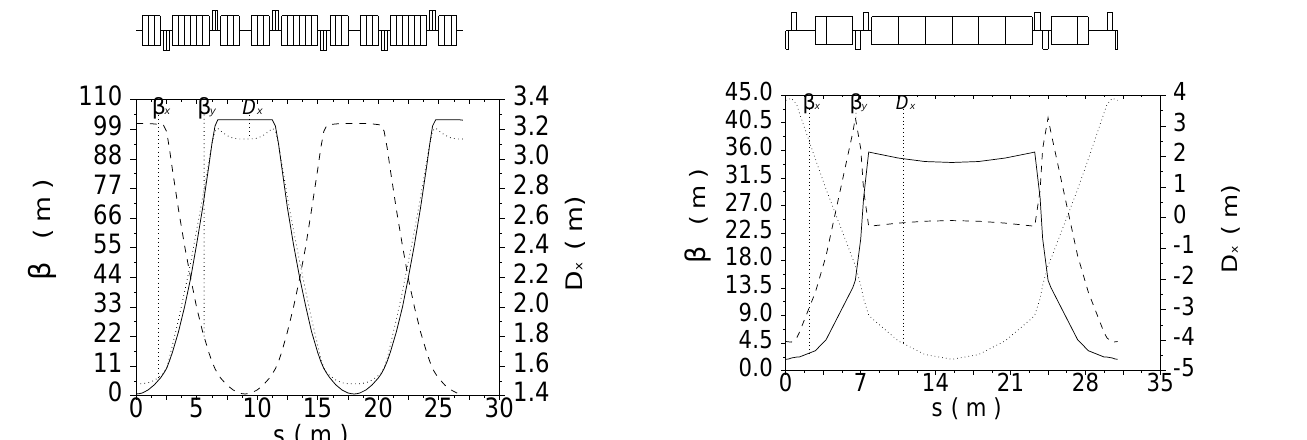
FIG. 46. Example (a): A flexible momentum compaction arc